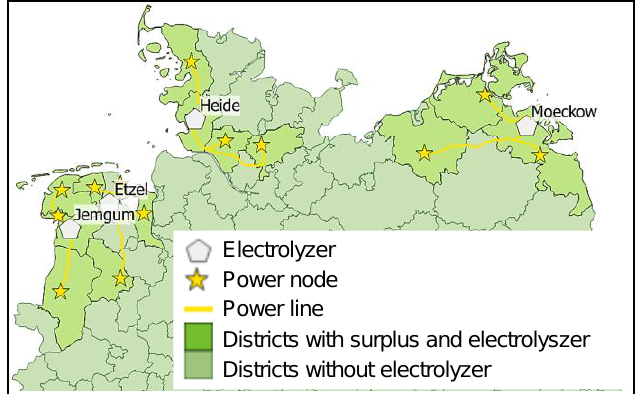
Figure 14. Selected districts to cover the peak-demand of hydrogen of 2.93 million tons in the year